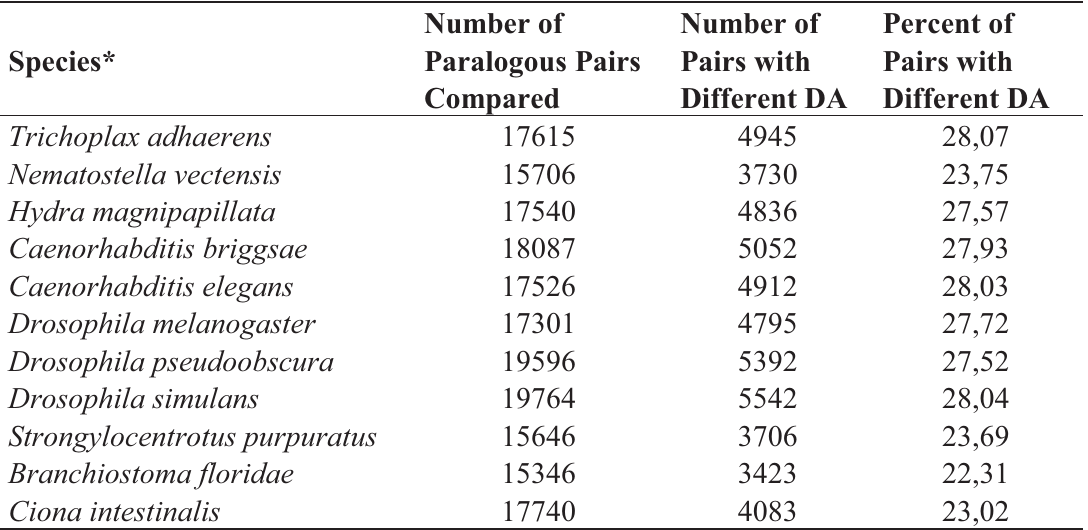
Table S7. Comparison of the DA of paralogous human Swiss-Prot proteins defined through comparison with RefSeq proteomes of various